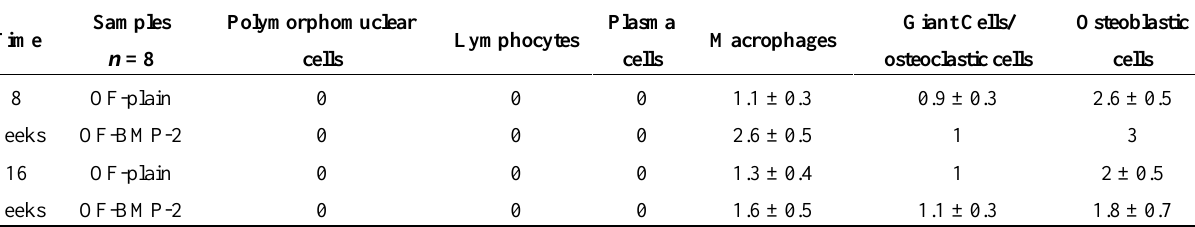
Table 3. Semi quantitative histopathologic evaluation (Scoring Table 2, n = 8, mean ±